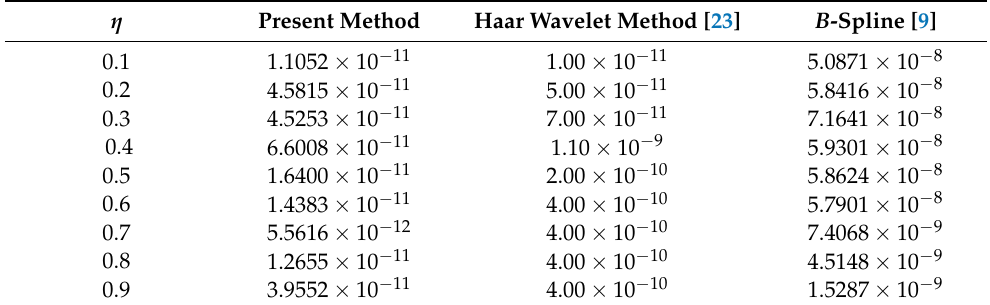
Figure 3. ( a ) Absolute error at k = 2, M = 3; ( b ) absolute error at k = 4, M = 5 of Example 1. Table 1. Comparison of the proposed method’s absolute error with the HWM and B -spline methods of Example 1 for ζ = 0.1.